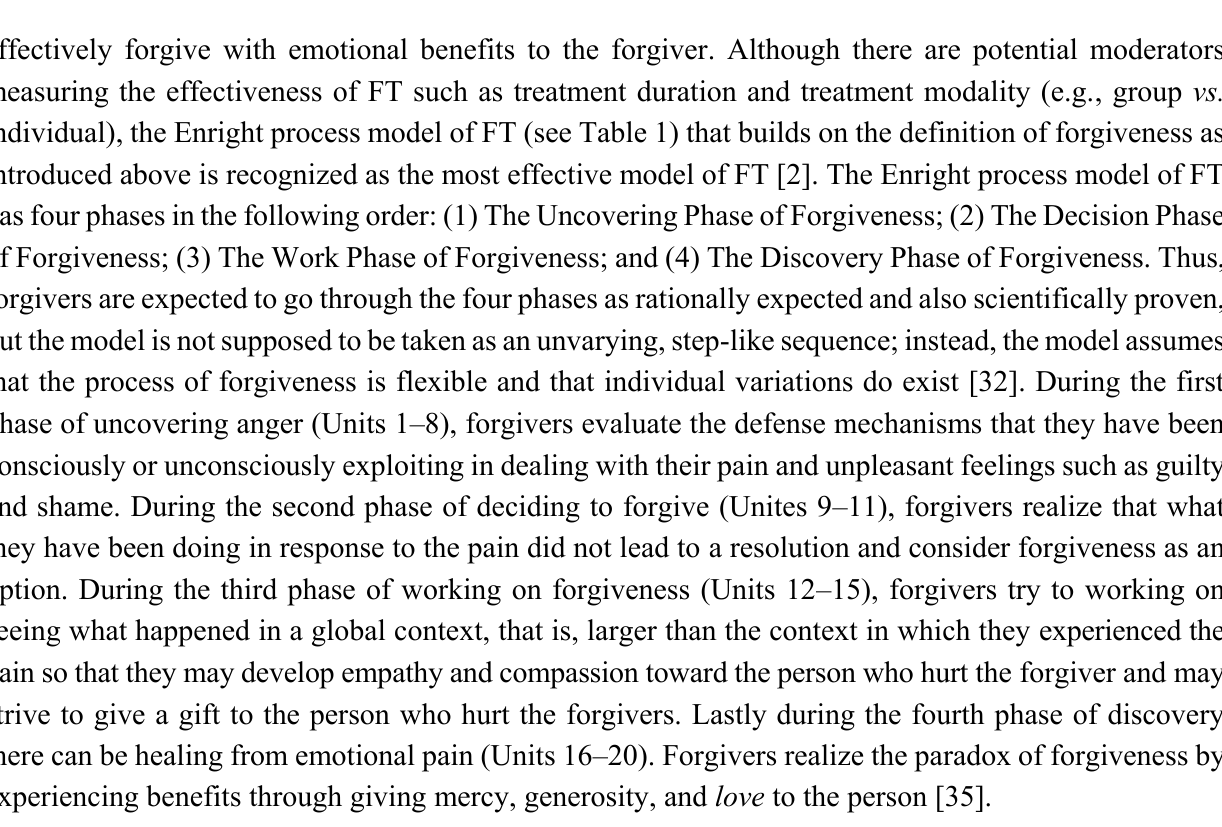
Table 1. The process model of